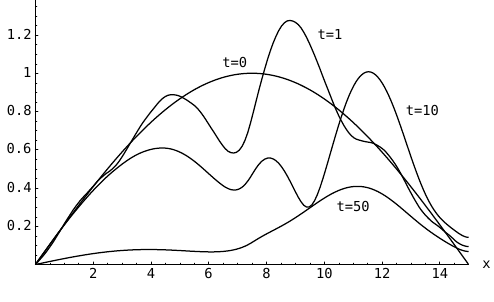
Figure 2. Evolution in time of j u ( x; t ) j for (cid:14) ( x ) = tanh(7 x (cid:0) 3 : 5 L ) : Thus we conclude that the DM method can be used efficiently to solve the prob- lem (1.1) also for (cid:14) ( x ) = const 6